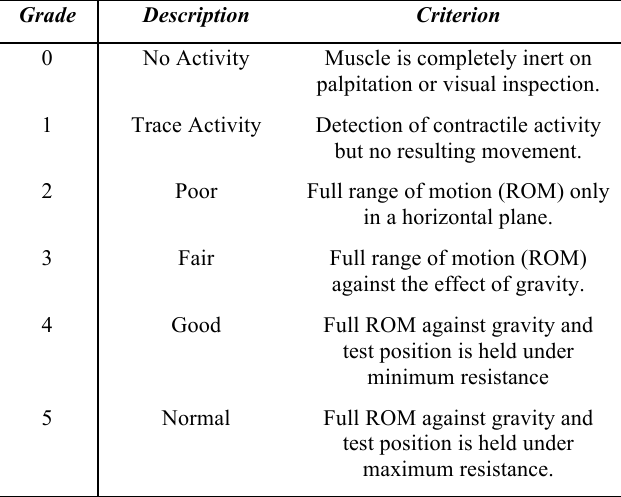
Table 1: Criteria for assigning different grades in